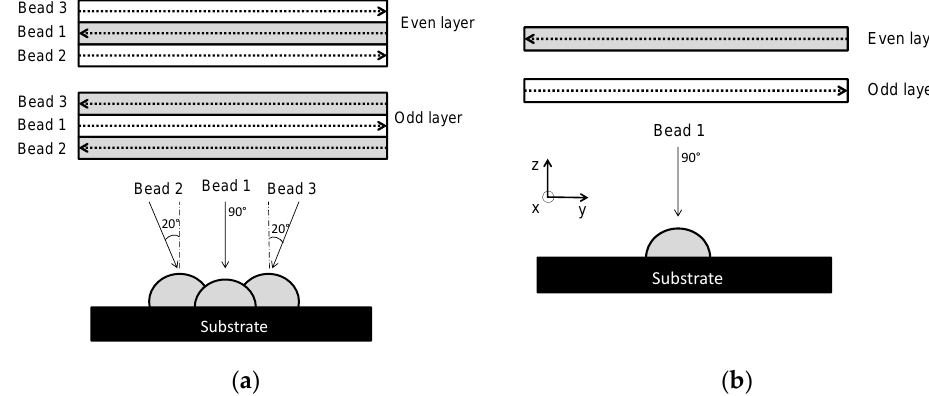
Figure 3. Build strategy followed for WAAM walls: ( a ) Three overlapped weld beads per layer applied to thick walls, ( b ) single weld bead per layer used for thin ones.